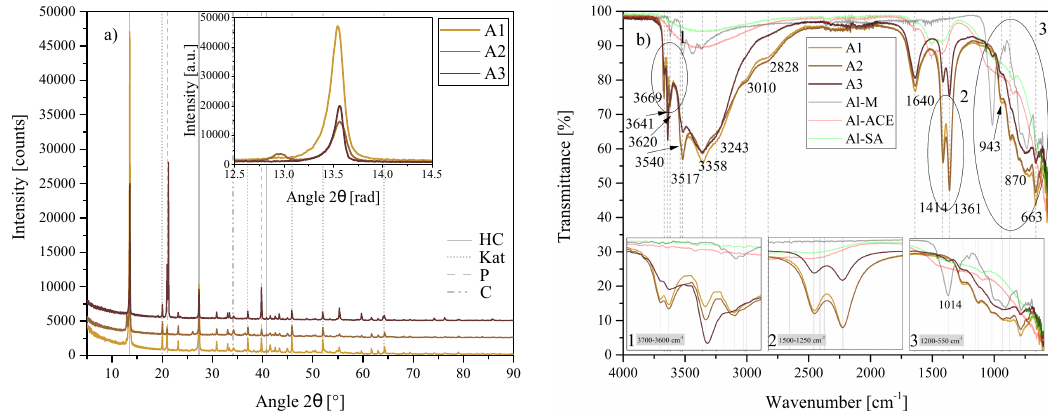
Figure 16. ( a ) XRD results of the chemical morphology/crystallinity of Al(OH) 3 series A1, A2 and A3 between 5 ◦ 2 θ and 90 ◦ 2 θ . Each scan is y-shifted by 2500 counts. The inset depicts the primary LDH peaks and change in position. HC = hydrocalumite, HC2 = hydrocalumite phase 2, Kat = katoite, P = portlandite, C = calcite and G = gibbsite. ( b ) FTIR-ATR scans of the chemical morphology/crystallinity of Al(OH) 3 A1, A2 and A3 between 4000cm − 1 and 550cm − 1 . The three insets show the regions: ( 1 ) 3700cm − 1 – 3600cm − 1 , ( 2 ) 1500cm − 1 – 1250cm − 1 , ( 3 ) 1200cm − 1 – 550cm − 1 in detail. Dashed and solid grey lines indicate the maxima of vibrations. A1 = Al(OH) 3 -SA, A2 = Al(OH) 3 -ACE and A3 = Al(OH) 3 -SA.